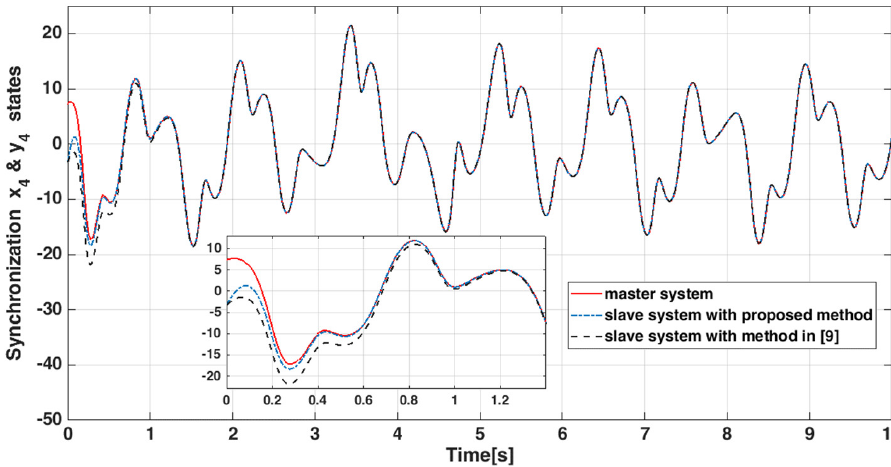
Figure 11. States 𝒙 𝟒 and 𝒚 𝟒 .